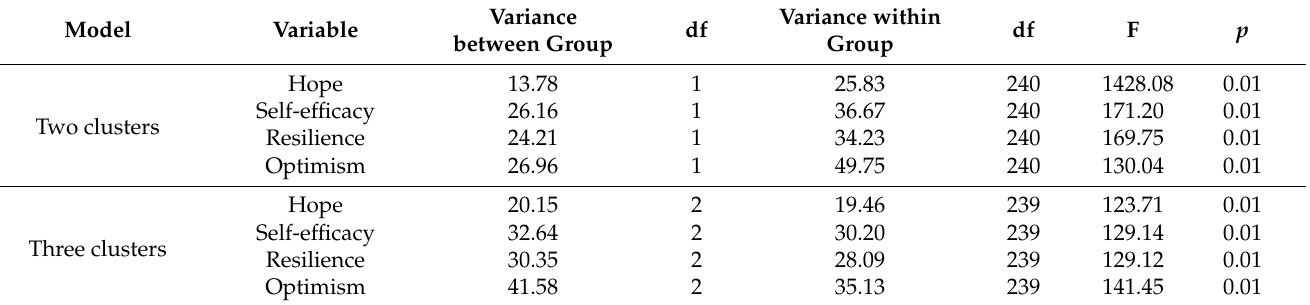
Table 5. Variance within and between groups for Psychological Capital Scale: results of k-means clustering analysis.